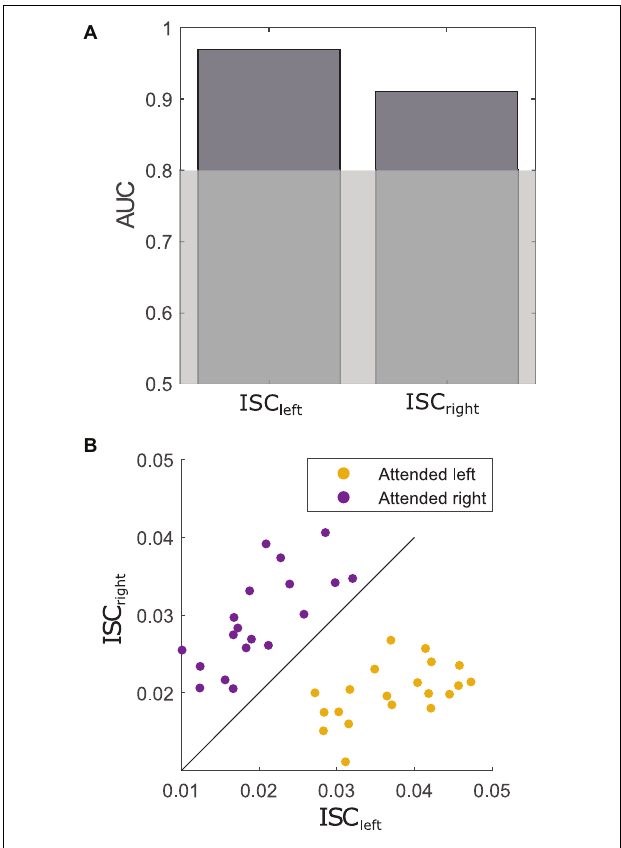
FIGURE 5 | (A) Prediction accuracies assessed by AUC indicate the performance of ISC to correctly classify whether or not a participant attended to the left story (ISC left ) or the right story (ISC right ). Gray-shaded area indicates significance level at p < 0.001. (B) Each datapoint represents the relation of a participant’s ISC left and ISC right score. The colors indicate the condition of the participant. The diagonal line illustrates how informative each datapoint was for the